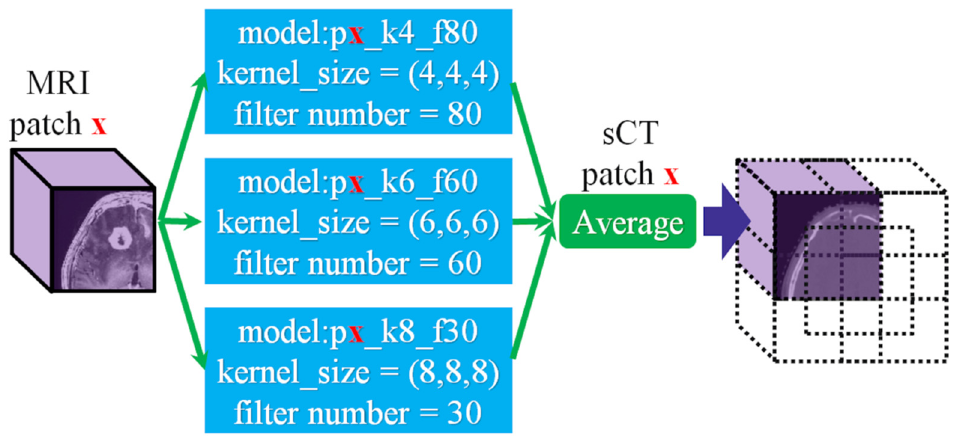
Figure 4. Merging prediction from the k4_f80, k6_f60, and k8_f30 models. A patch of synthetic CT is composed of output from the k4_f80, k6_f60, and k8_f30 models.